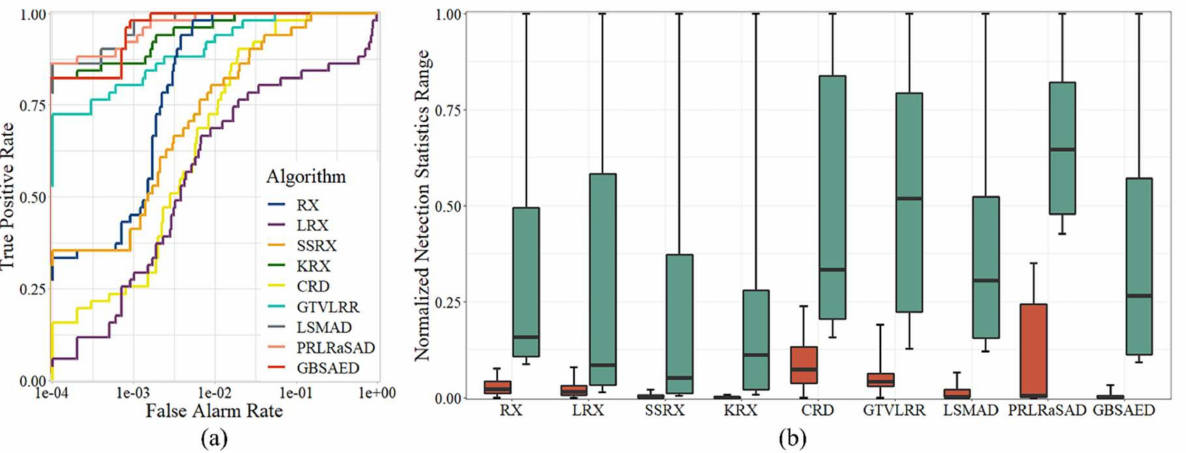
Figure 10. Quantitative analysis of the detection results of the various algorithms for the PaviaC Image: ( a ) ROC curves and ( b ) target-background separation map.